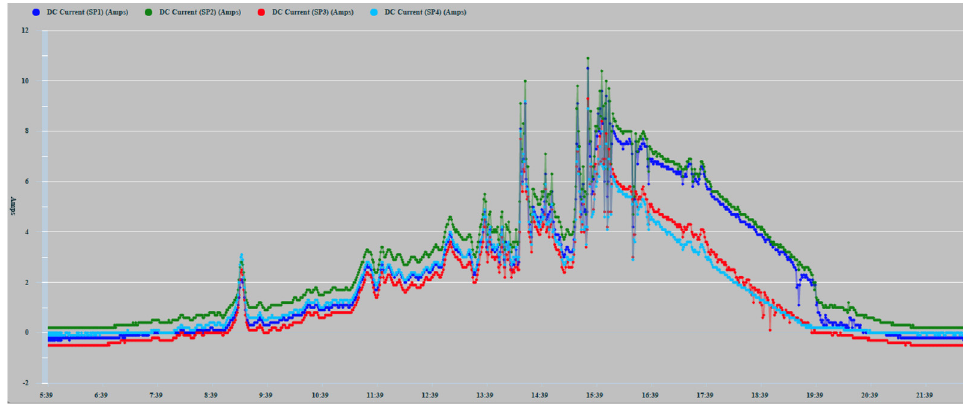
Figure 11. 17 May 2021 zoom.